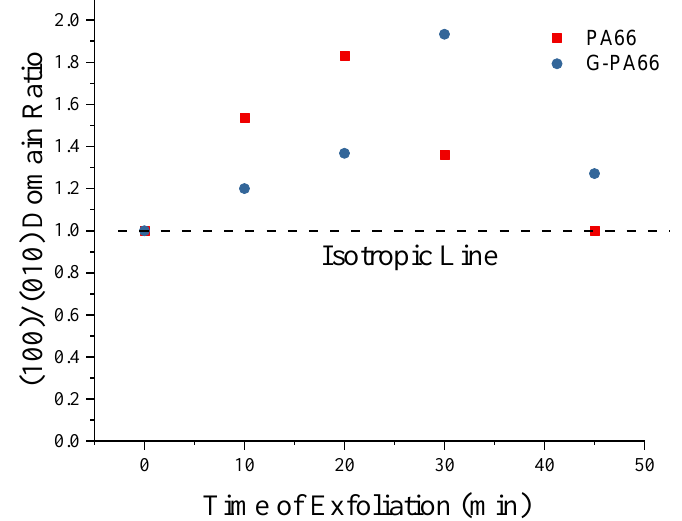
Figure 4. PA66 (100)/(010) domain size isotropy parameter vs. graphite concentration; (010) is (010)/(110). Table 2. Diffraction data for Graphite, PA66 and G-PA66.